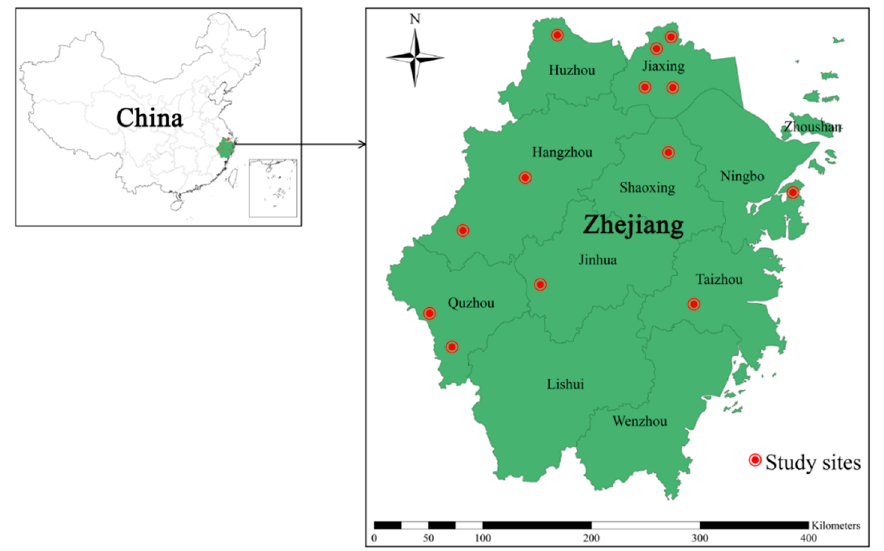
Figure 1. Distribution of experimental sites for rice in Zhejiang Province, China.